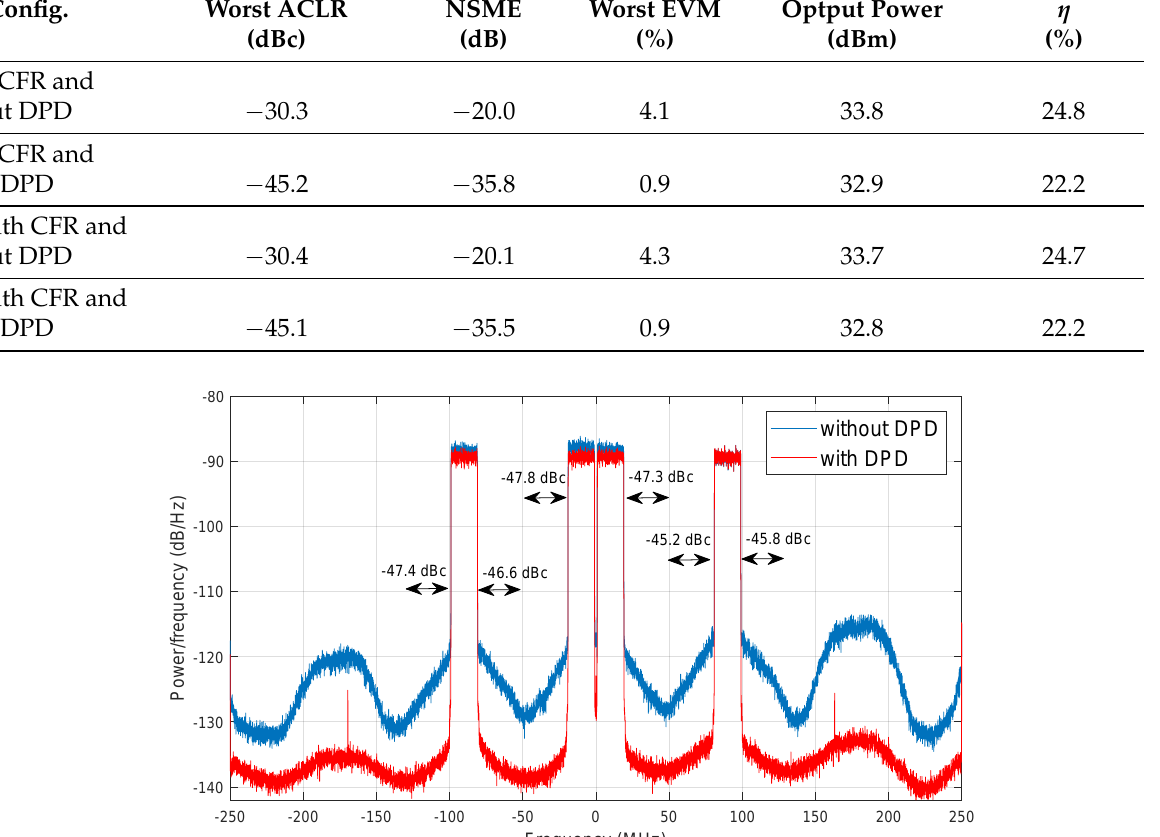
Figure 13. Output power spectra before and after DPD linearisation for the CA-4 × LTE-20 signal test case.